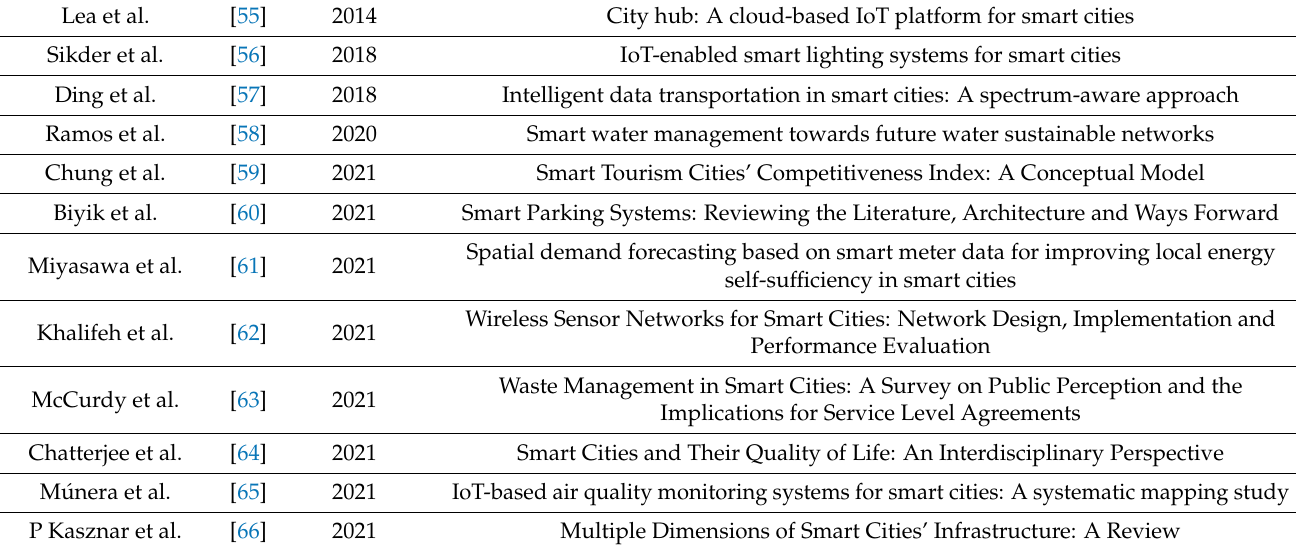
Table 3 represents the previous studies on smart city solutions. Table 3. Smart Cities Solution (previous